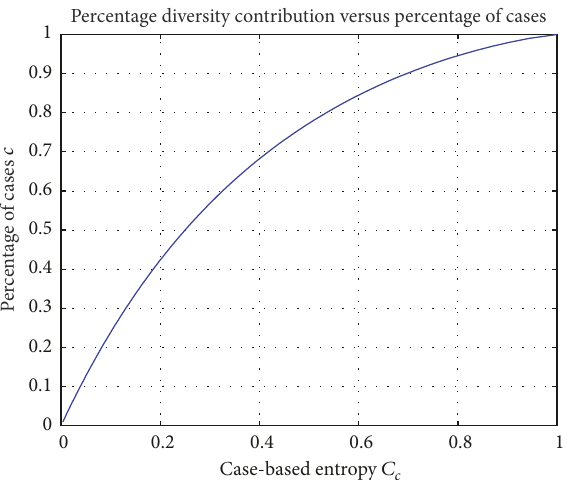
Figure 1: 𝐶 𝑐 as a function of 𝑐 for the Boltzmann distribution in one